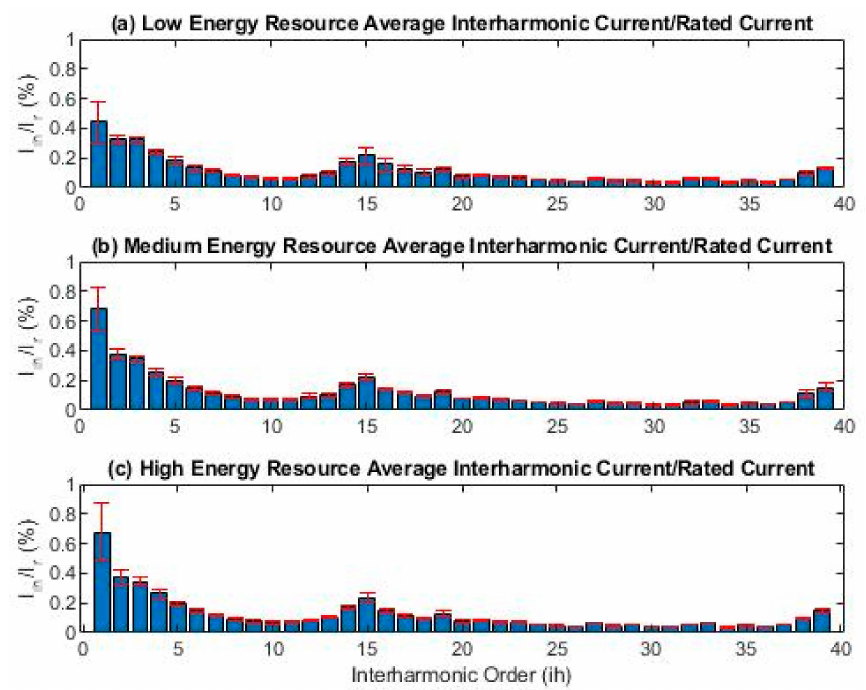
Figure 8. Sea trial average ratio of interharmonic current amplitude to rated current for ( a ) low energy, ( b ) medium energy, and ( c ) high energy resource classifications including errorbars that represent the standard deviation of the data